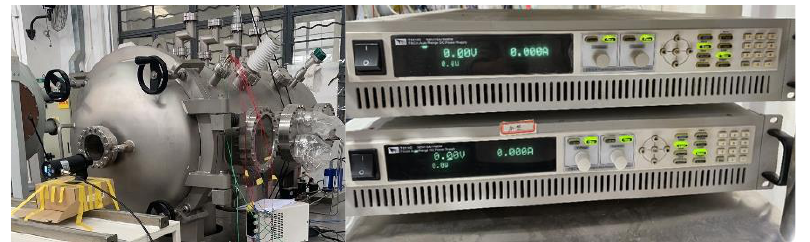
Figure 2. Vacuum chamber and experimental equipment.